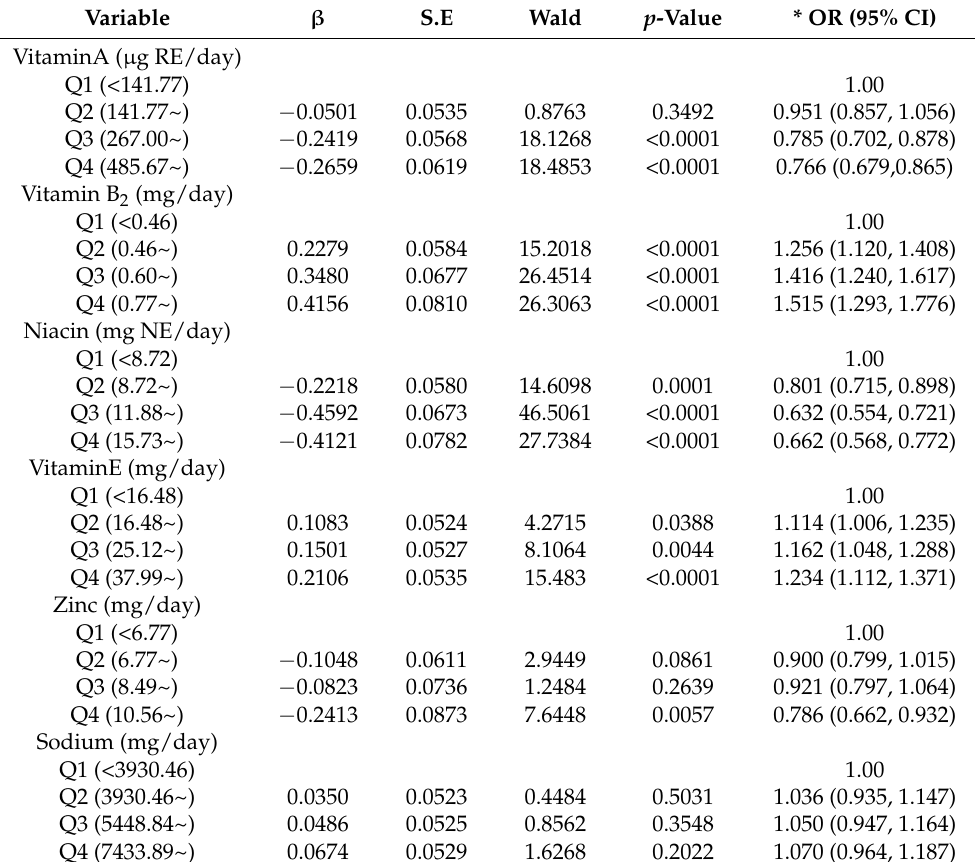
Table 5. Logistic regression analysis of the influence of dietary nutrient intake on overweight/obesity in non-pregnant and non-lactating women aged 18–49